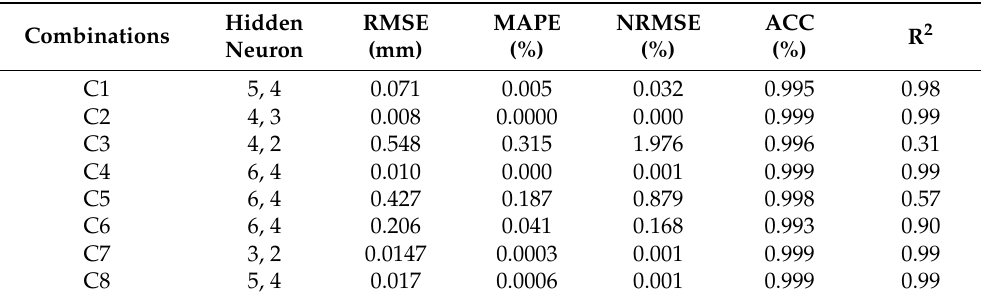
Table 2. The most accurate results at given hidden neurons among all developed models of ANN for all combinations at given